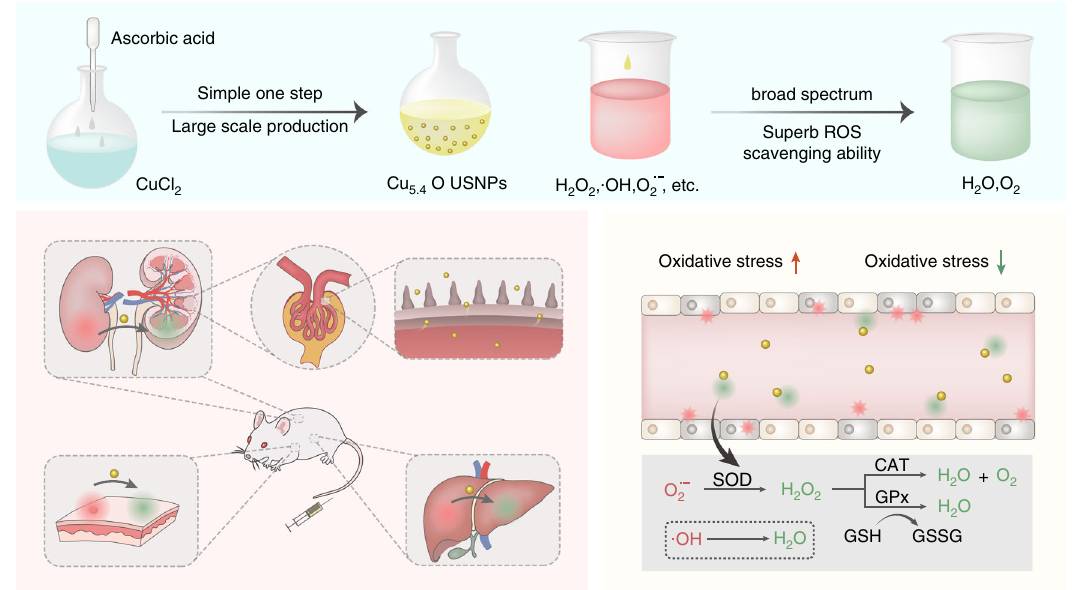
Fig. 1 Schematic illustration of Cu 5.4 O ultrasmall nanoparticles in the treatment of ROS-related diseases. Cu 5.4 O ultrasmall nanoparticles with multiple enzyme-mimicking and broad-spectrum ROS scavenging ability are synthesized by a simple and green method. Due to the robust ROS scavenging ability in vivo, Cu 5.4 O ultrasmall nanoparticles exhibit therapeutic effect against broad ROS-related diseases, including acute kidney injury, acute liver injury and diabetic wound